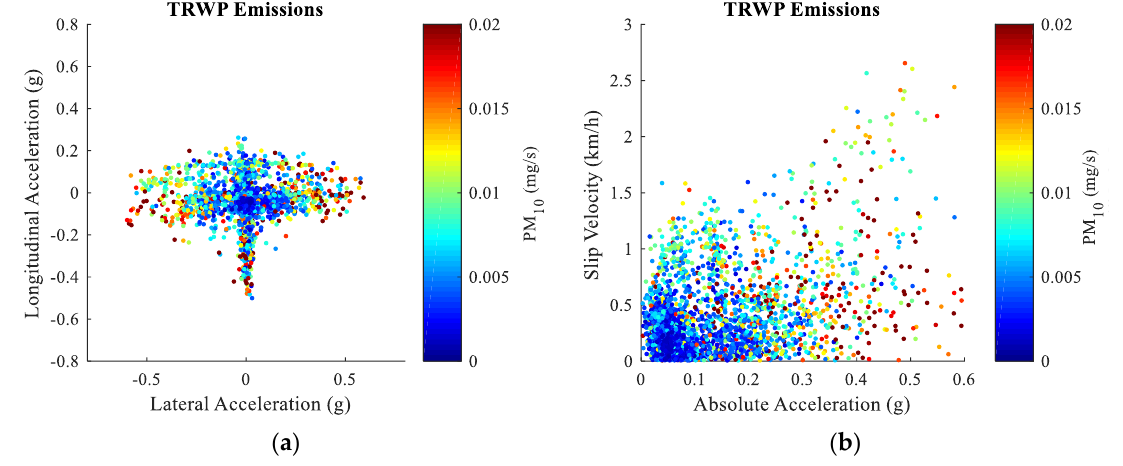
Figure 6. Correlation between vehicle dynamics and particle generation: TRWP emissions as a function of ( a ) longitudinal and lateral acceleration and ( b ) slip velocity.